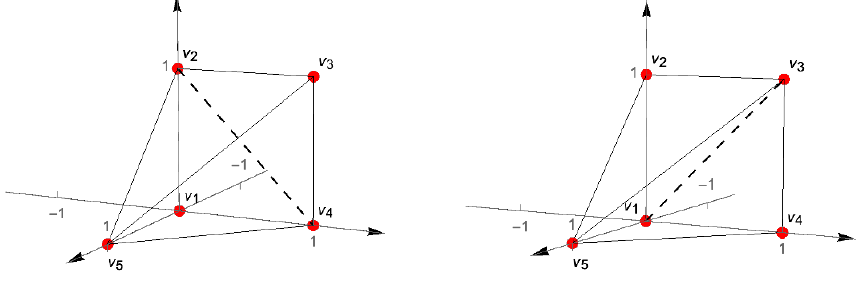
Figure 6 . Toric diagrams for two resolutions of the link of the C (cid:2) Conifold singularity. A.3 Y = link of C (cid:2) 7